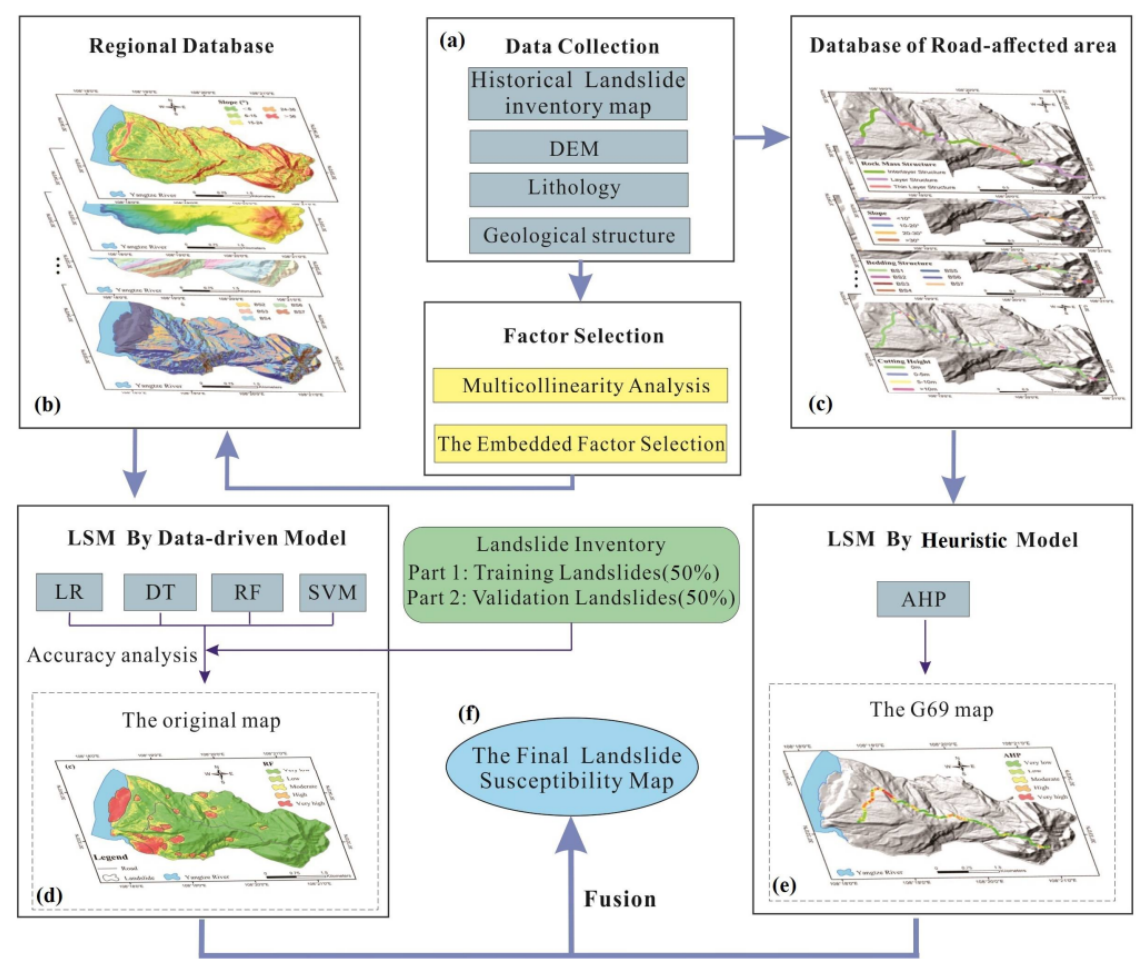
Figure 3. The flow chart of the proposed